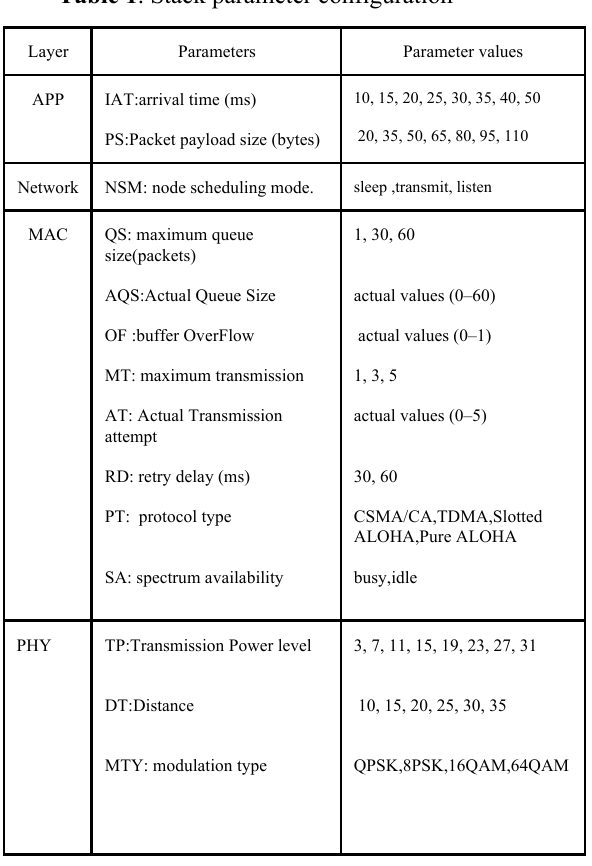
Table 1 . Stack parameter